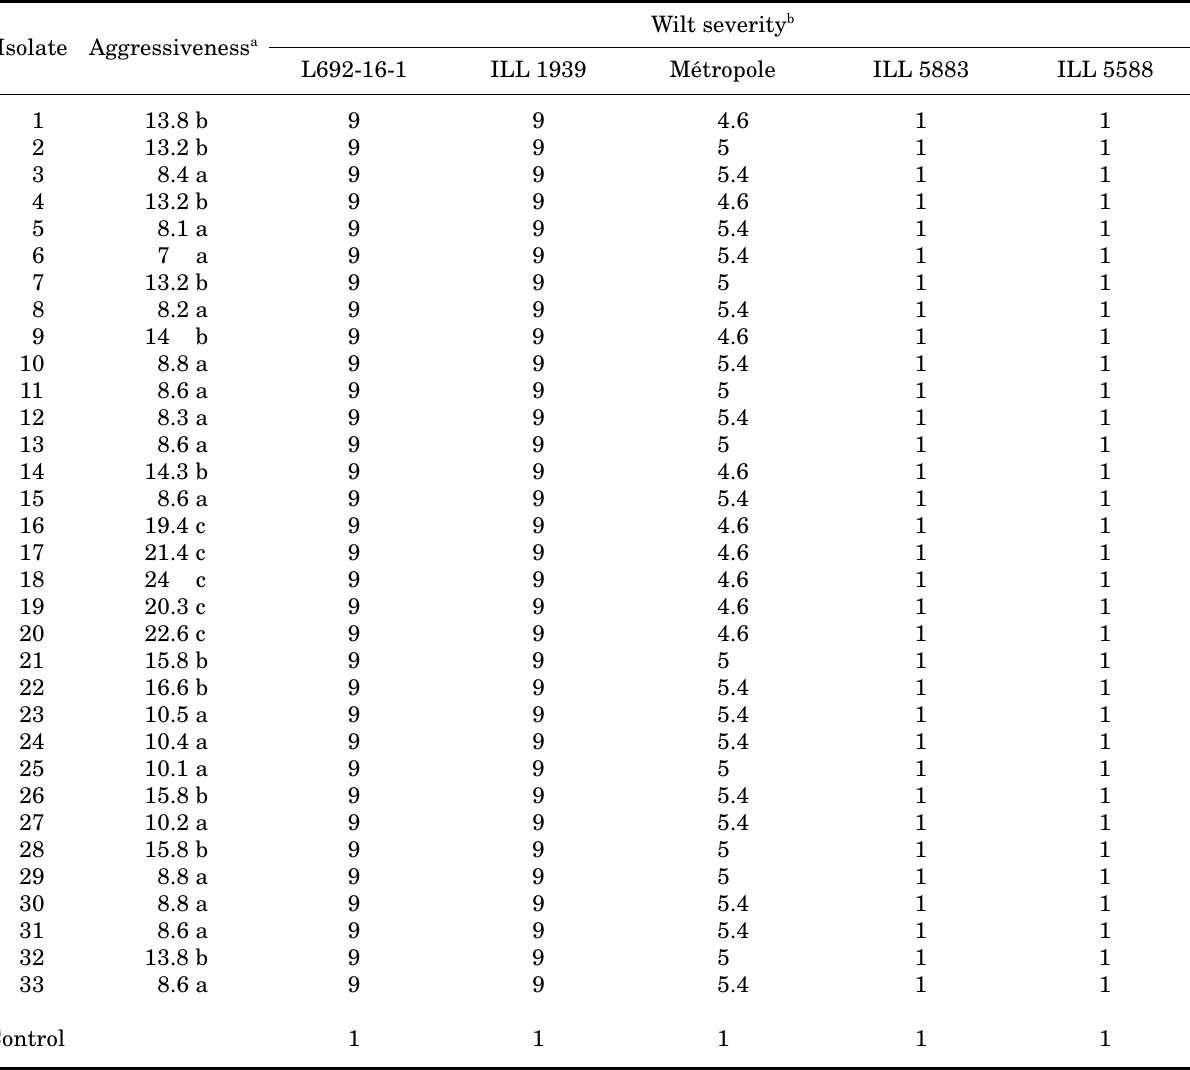
Wilt severity b